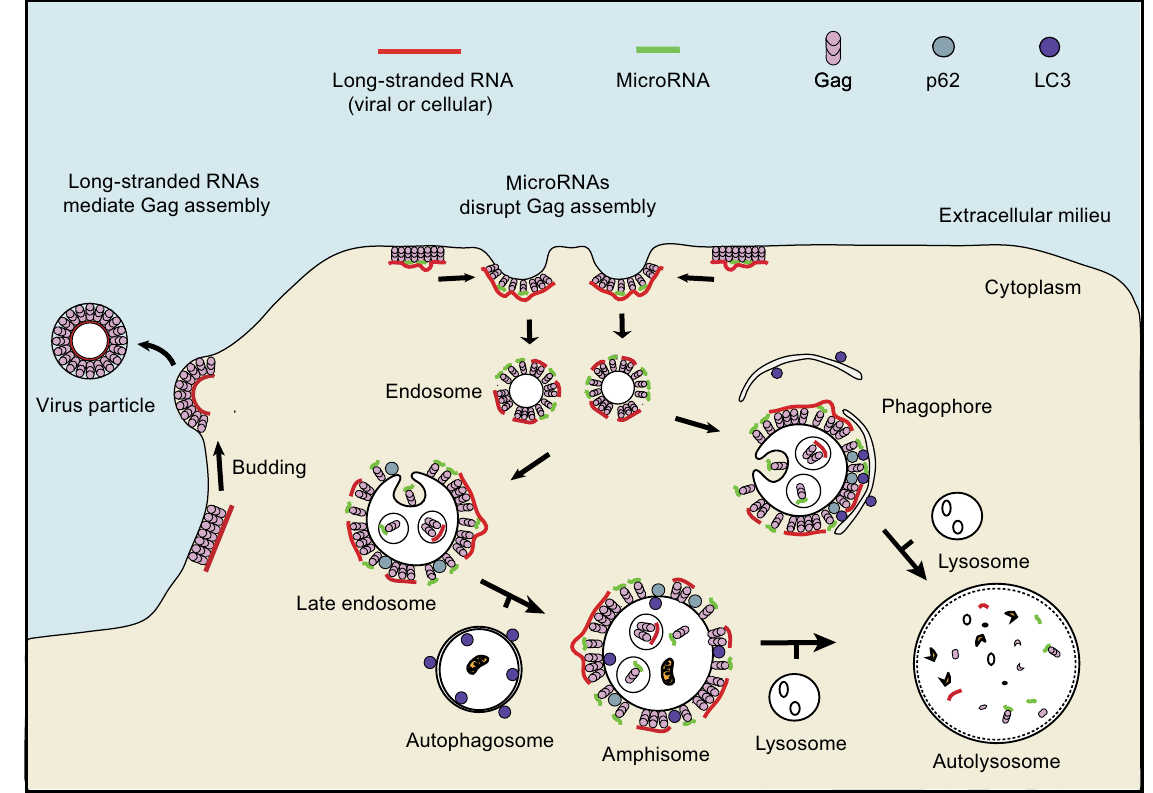
Figure 6. Schematic model of how microRNAs and macroautophagy function to block virus production. In the absence of Gag-miRNA complexes, Gag and scaffold RNAs (viral genome or long-stranded mRNAs) form stable complexes at the PM, resulting in viral budding. When Gag-miRNA complexes are present within the assembling complexes, particle formation is disrupted, resulting in internalization of misassembled complexes through endocytosis. The endocytosed Gag-miRNA complexes could be engulfed by phagophores, which mediates their autophagic degradation through a p62-dependent process. Additionally, fusion of autophago- somes to the late endosomes could form amphisomes, which can then mature into autolysosomes that degrade the enclosed misassembled